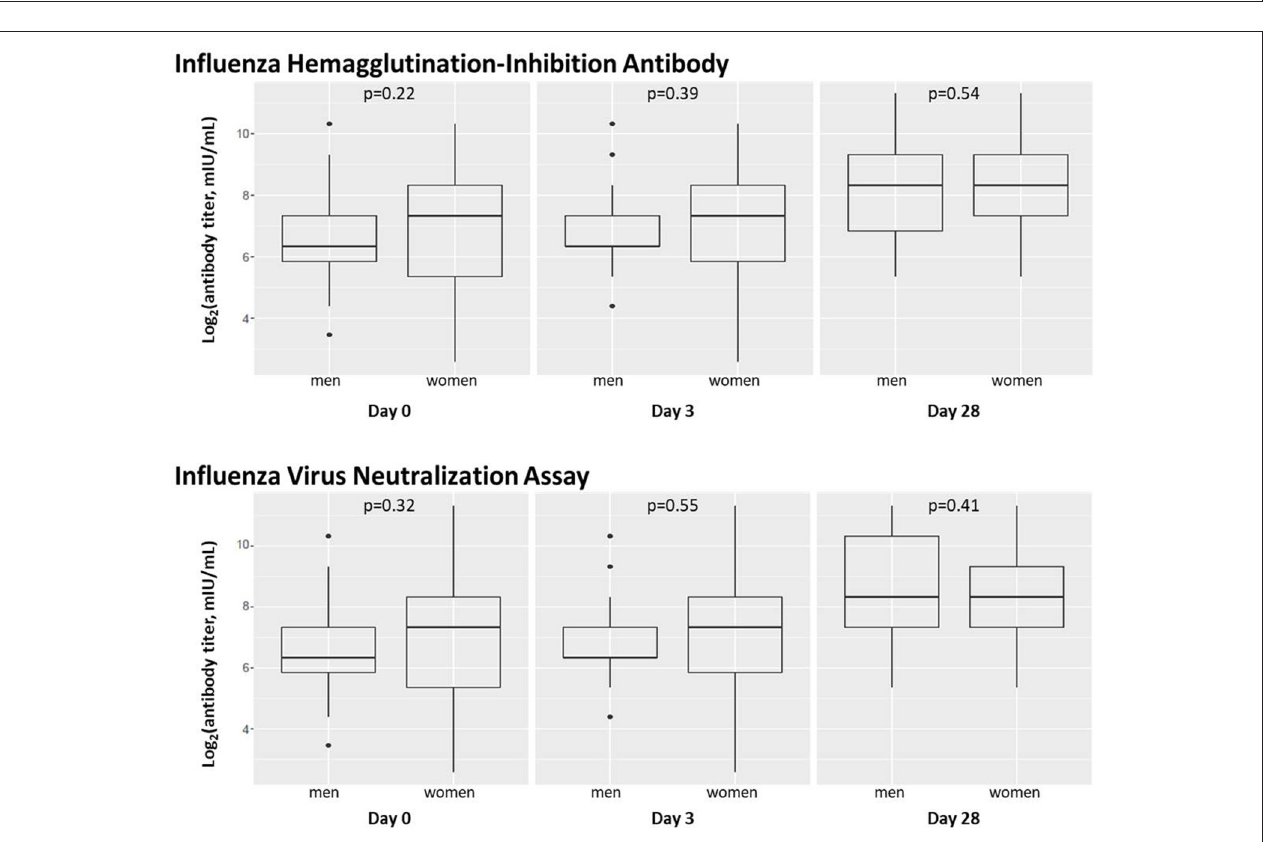
FIGURE 2 | Subject sex does not significantly affect influenza A/H1N1 antibody titers. Box plots are shown for levels of influenza A/H1N1-reactive antibody in subject sera before and after vaccination using hemagglutination-inhibition and virus neutralization assays. Dot plots indicating individuals’ responses are available in Supplementary Figure 2